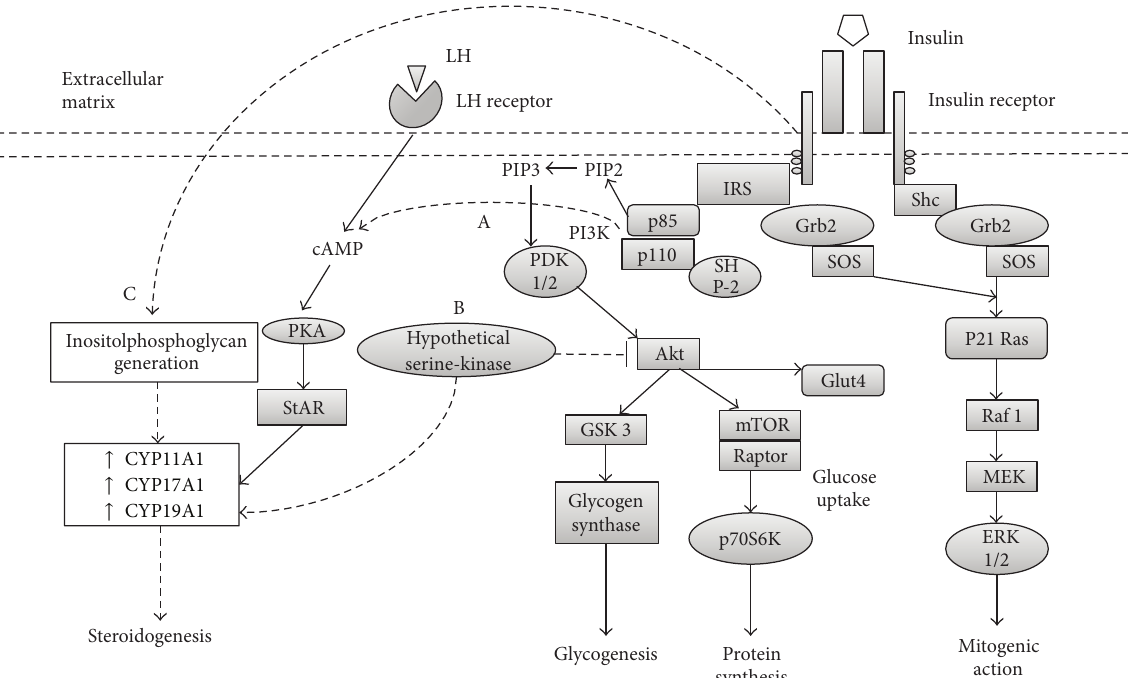
Figure 2: Insulin signaling in ovarian thecal cells and proposed mechanisms for selective insulin resistance. Solid lines represent well- characterized mechanisms. Dashed lines represent incomplete information or hypothetical mechanisms. (A) Insulin may act in synergy with LH to increase intracellular concentration of cAMP, potentiating PKA activation and subsequent phosphorylation of StAR, favoring steroidogenesis. (B) A hypothetical serine-kinase could unify hyperinsulinemia-hyperandrogenemia in PCOS, as it would inhibit Akt activity, negatingthemetaboliceffectsofinsulin,whileactivatingsteroidogenicenzymes.Furthermore,themitogenicpathwaywouldbeleftintactand fully functional, favoring thecal proliferation. (C) Inositolphosphoglycan generation appears to be triggered by INSR-prompted mechanisms independent of signaling molecules within metabolic or mitogenic pathways on insulin signaling. Therefore, inositolphosphoglycans may stimulate steroidogenic activity regardless of metabolic and signaling disturbances typical of systemic insulin